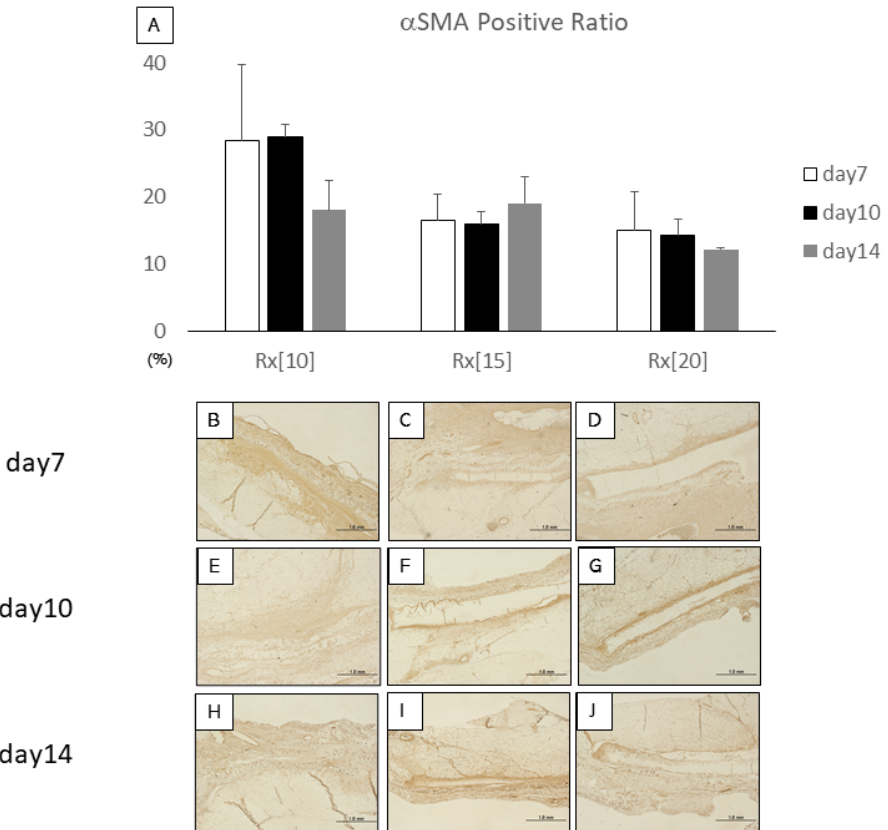
Figure 5. α -Smooth muscle actin ( α SMA)-stained sections after implantation of radiation-crosslinked hydrogels (RXgels): ( A ) Expression ratio of α SMA was analyzed by α SMA staining. There was no significant difference between other days in the same RXgel group; ( B – J ) α SMA staining of 5- μ m-thick sections at days 7, 10, and 14 after implantation of each RXgel. α SMA-positive areas are shown in dark brown. Each scale bar indicates 1.0 mm.